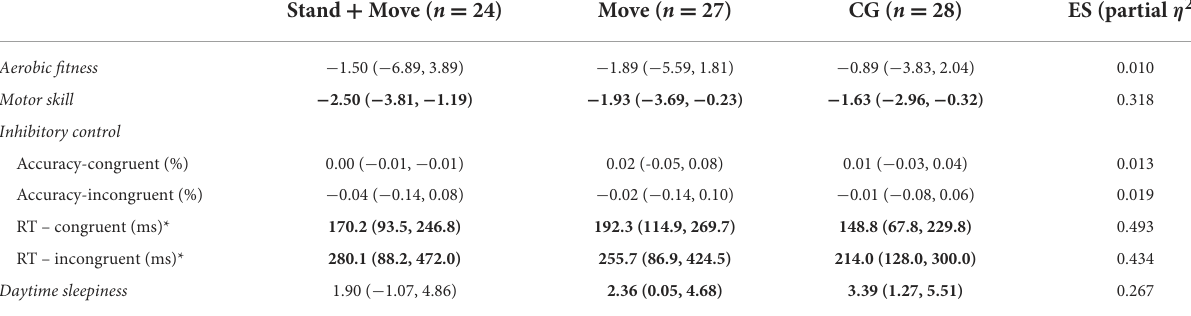
TABLE 4 Adjusted mean changes (95% CI) from baseline to